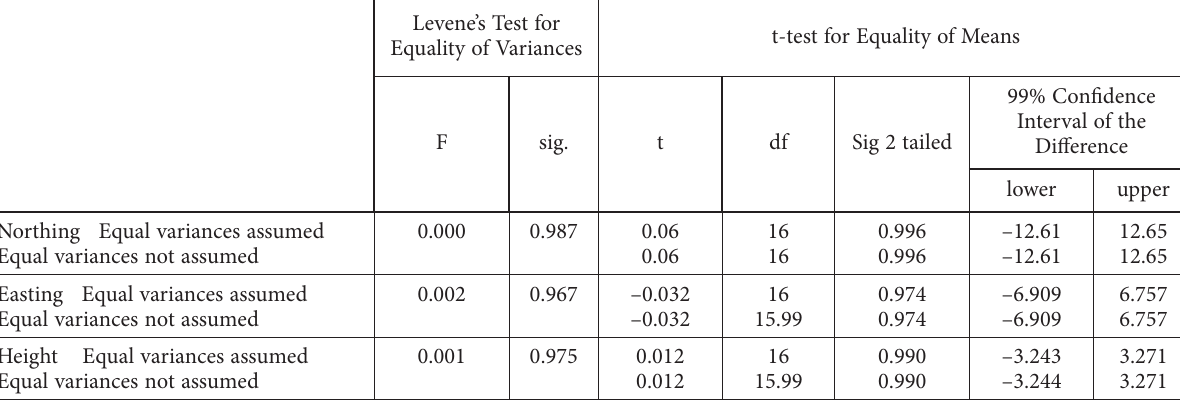
Table 5. Statistical test of equality on results of ground survey and space intersection coordinates (Tecno W3) Levene’s Test for Equality of